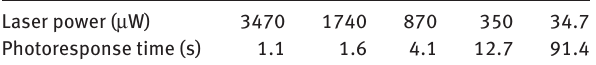
Table 1: The photoresponse times of the TiO decorated graphene field-effect transistor (GFET) photodetector under 325-nm laser illuminations with different powers ( V = 0.1 V ds